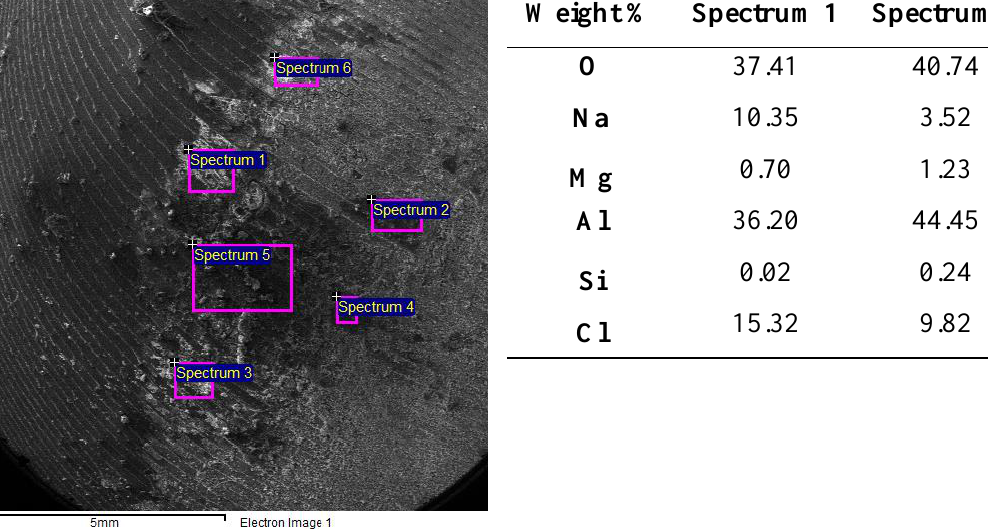
Figure S1: Optical images of typical FSDC processed samples for FH-1 (A50), FM-1 (B50), and FL-1 (C50); Figure S2: Di ff raction angles of the (111) peak showing the shift to lower angles as a function of rotation and traverse speeds; Figure S3: Load vs penetration depth curves for unprocessed Al and FSDC samples.; Figure S4: Low magnification SEM images of corroded SEM images of corroded surfaces